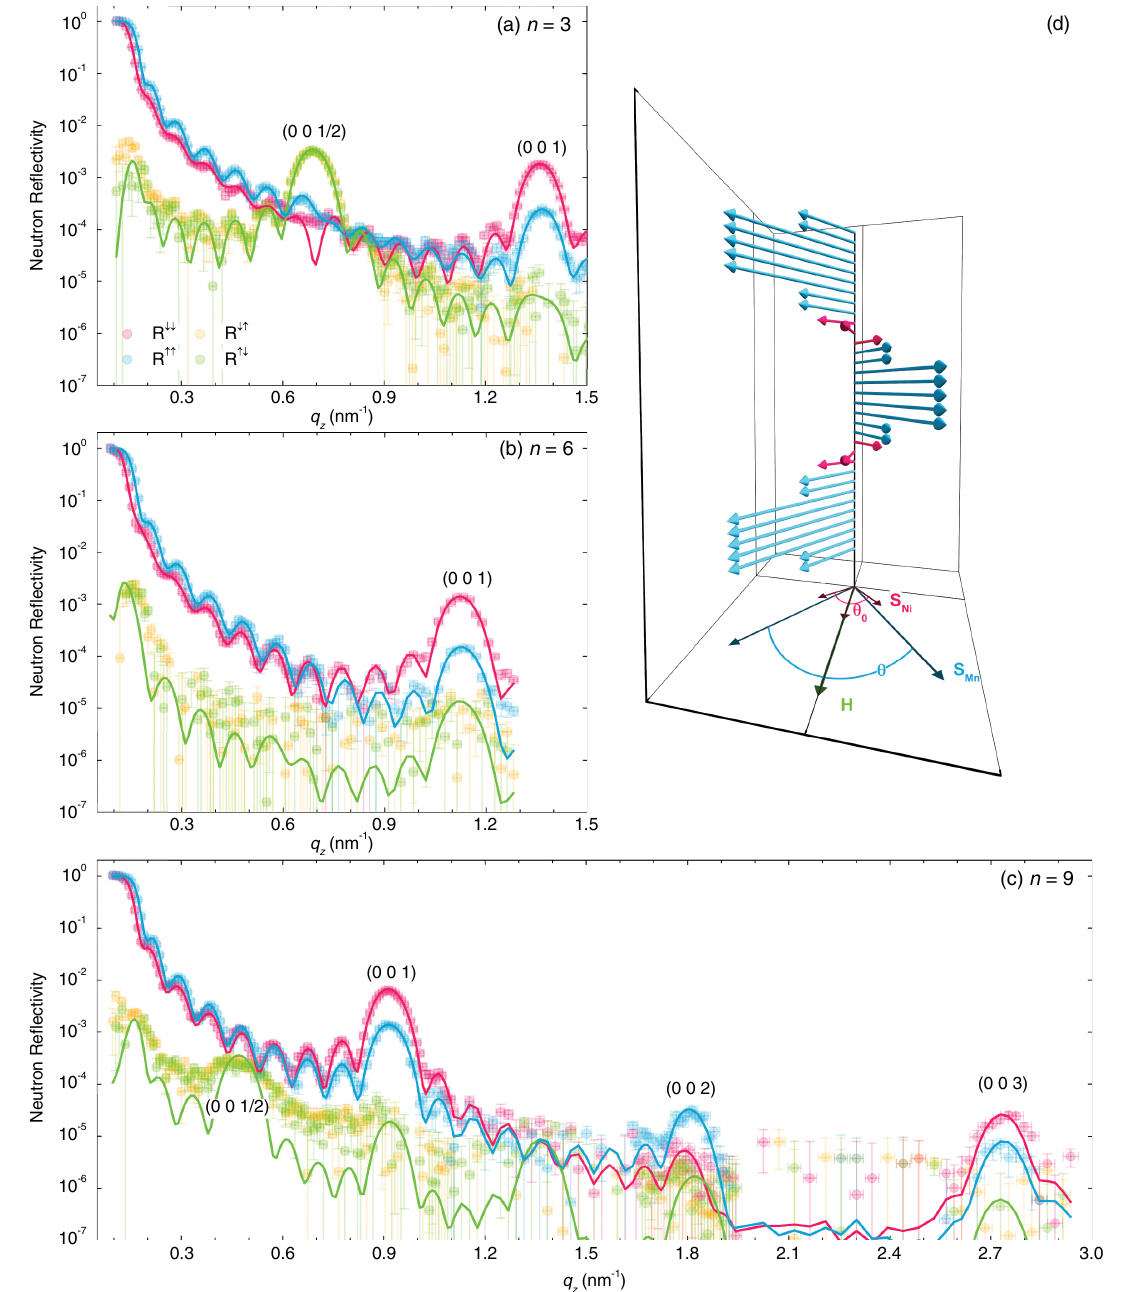
= ð La 2 Sr 1 MnO 3 Þ 9 superlattices on SrTiO 3 . Measured (symbols) and fit = 3 = 3 n